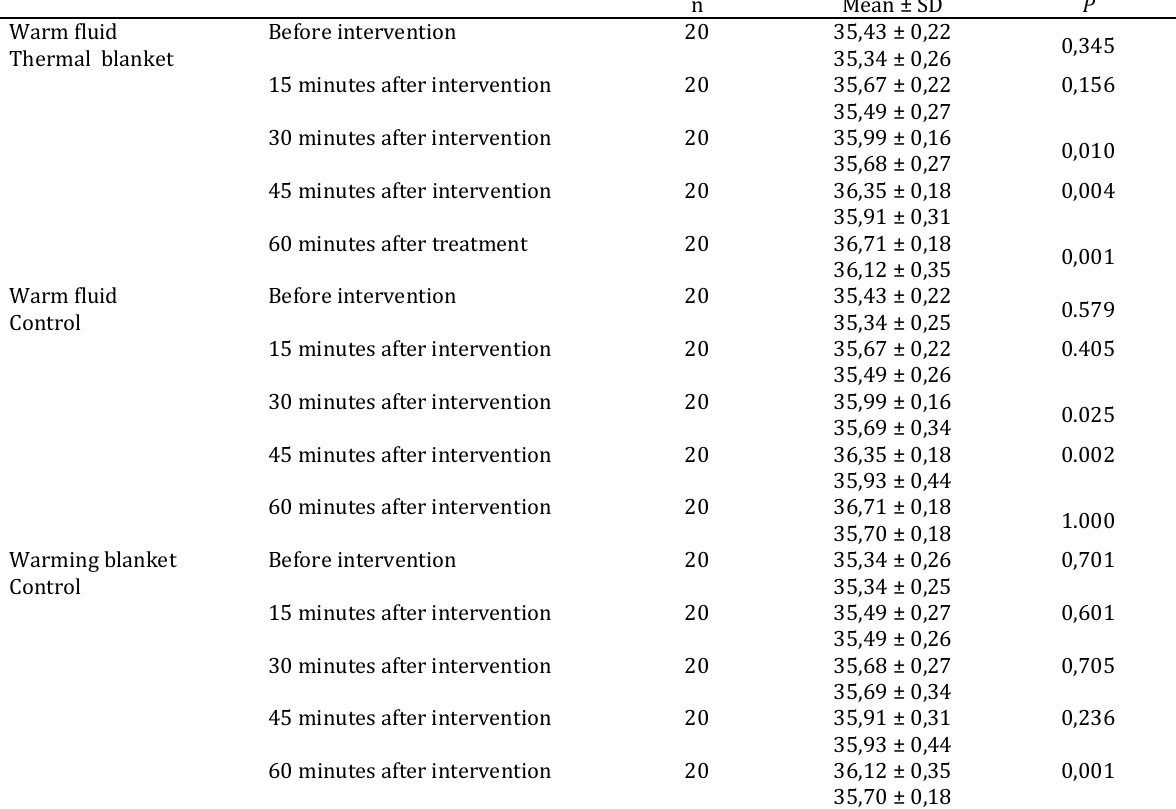
Table 3. The results of the independent t test on shivering patients post-spinal